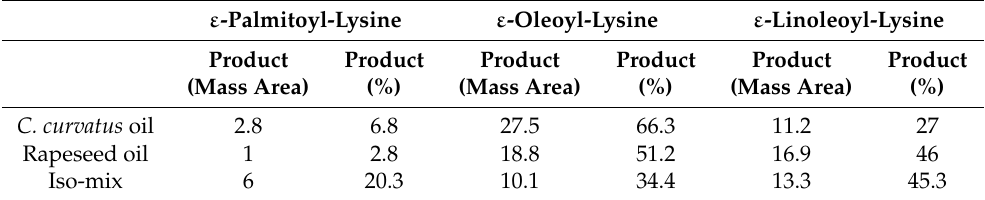
Table 8. Enzymatic acylation by CALB, Product (Mass Area) referred to the N- ε -acylation of lysine by an AD, Product (%), is the percentage of each product in the sum of 3 main products that occurred in each oil or FA mixture. HPLC-MS analysis provided Mass Area M + H + .